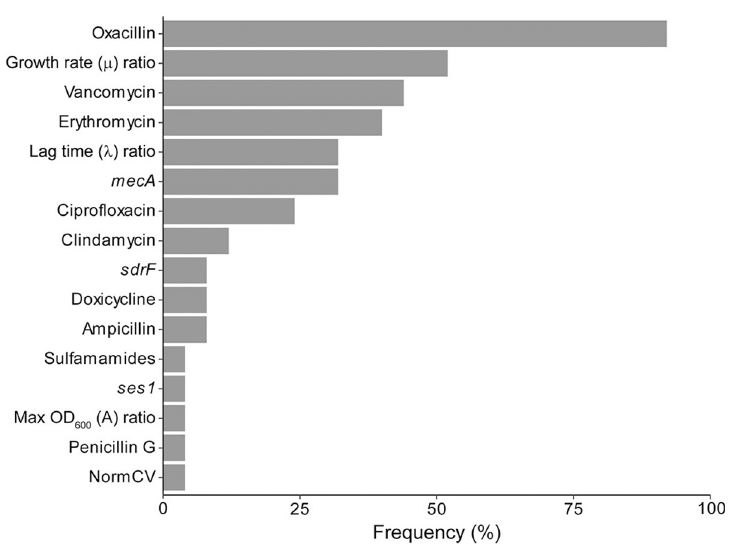
Fig 5. Frequency of specific variable